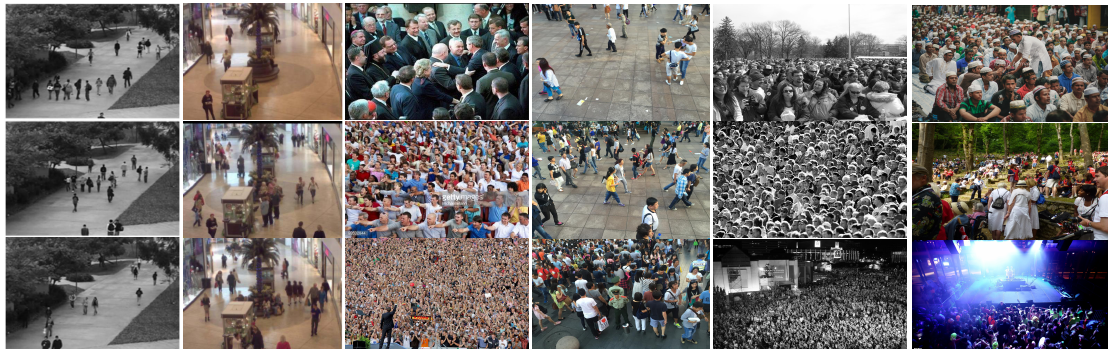
Figure 2. Sample images from various datasets. In order from left to right, each column is in turn UCSD [53], Mall [16], Shanghai Tech PartA [19], Shanghai Tech Part B [19], UCF_CC_50 [17], UCF-QNRF [32]. It is obvious that in UCSD and Mall dataset, the images providing no variation in perspective across